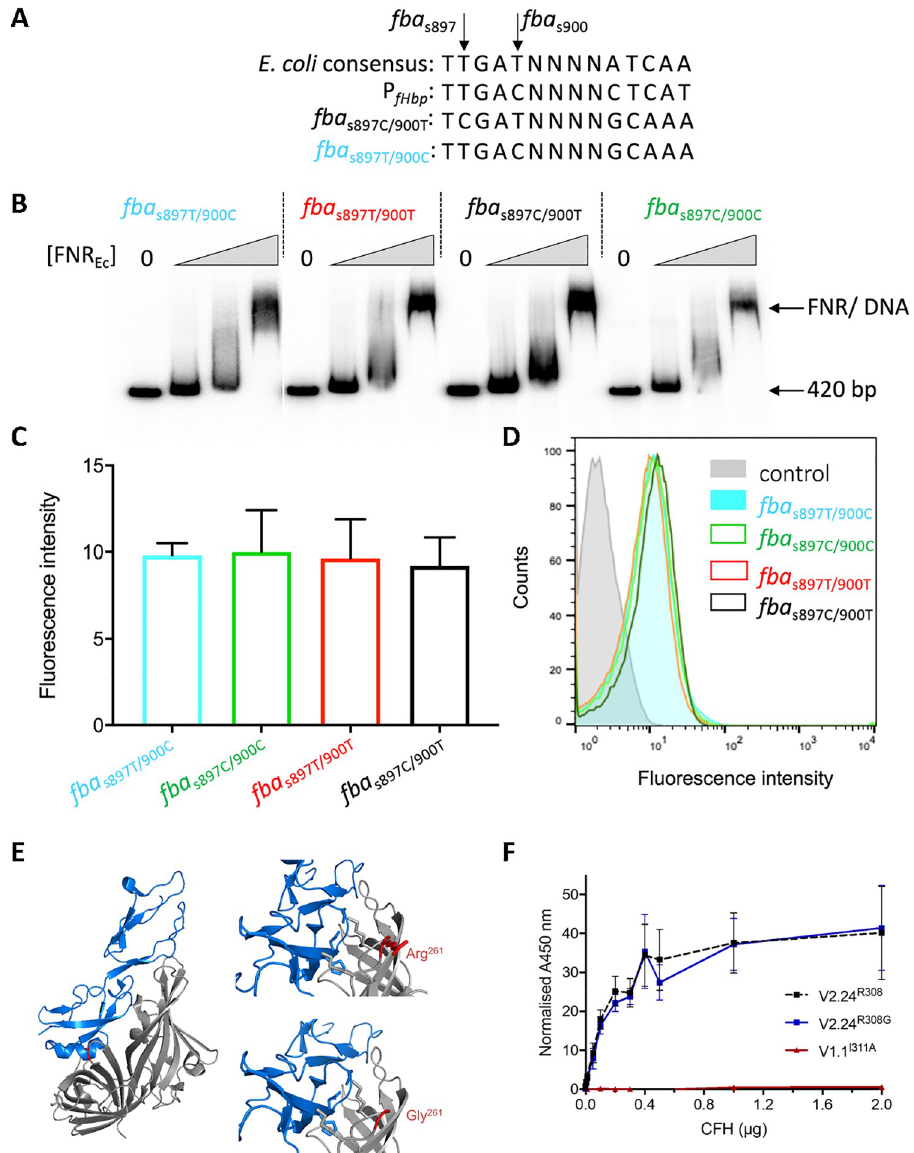
Fig 3. SNPs in fba do not alter FNR binding or fHbp surface expression. (A) Sequences of SNPs in fba aligned with the consensus E . coli FNR binding sequence and the known FNR site upstream of fHbp . (B) EMSA of 420 bp upstream of fHbp (including the known FNR binding site) with increasing concentrations of FNR (0, 0.75, 1.5, 3 μ M). (C) fHbp was detected on the surface of bacteria with different SNPs (indicated) by flow cytometry using α -fHbp pAbs. Geometric mean fluorescence was used to compare fHbp levels across the samples. Error bars show SEM, significance analysed by two-way ANOVA showed no statistical difference between the strains. (D) Representative flow cytometry histograms; strains indicated; control (grey filled area), no primary pAb. (E) Side chains of Arg 261 and Gly 261 (red) of fHbp (grey) shown with CCPs 6 and 7 of CFH (blue) and threaded onto fHbp (v3.28, PDB:4AYI); figures generated in PyMOL. (F) Binding of fHbps to CFH by ELISA; a non-functional fHbp (v1.1 Ala 311 ) was included as a control; error bars, SD, n = 3. significant differences (Fig 4B and 4C), with the 6 bp structure around the RBS being much more open and accessible (S13 and S14 Figs for SHAPE analysis and predicted RNA structures at 30˚C and 42˚C). These data demonstrated that the RNA structure around the RBS was